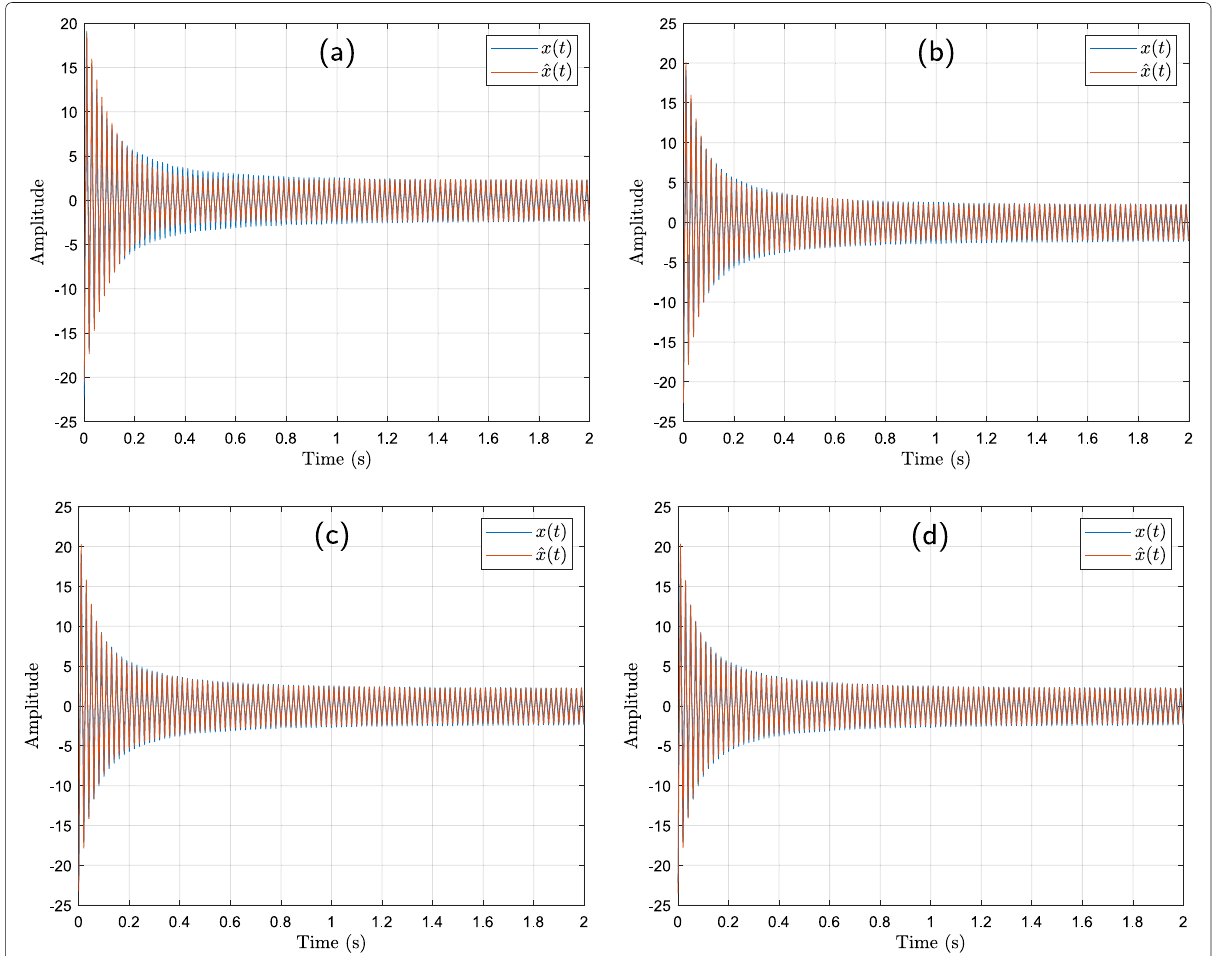
Fig. 10 Comparison between real, x ( t ) , and estimated, ˆ x ( t ) , transient current signals of a drill using different polynomial degrees n . The pairs (polynomial degree, root-mean-square errors) (i.e., (n, RMSE)) for the different panels are ( n = 1,0.2962 ) ( a ), ( n = 3,0.2473 ) ( b ), ( n = 5,0.2433 ) ( c ), and ( n = 7,0.2428 )( d